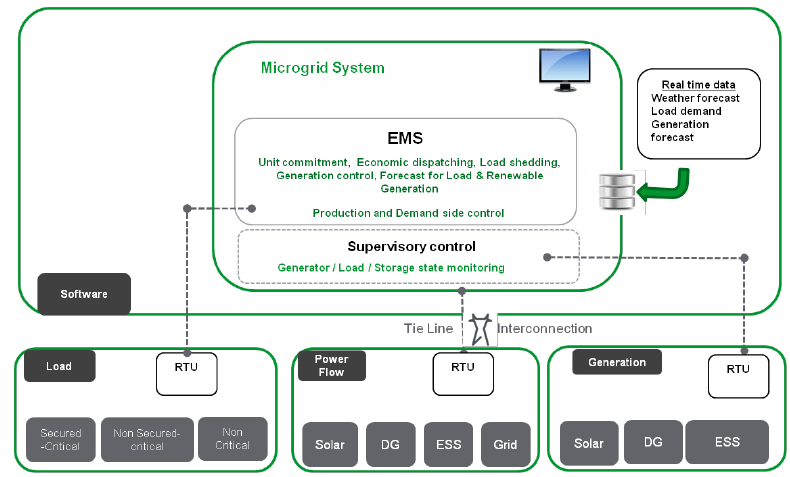
Figure 2. EMS controller Input and Output data.